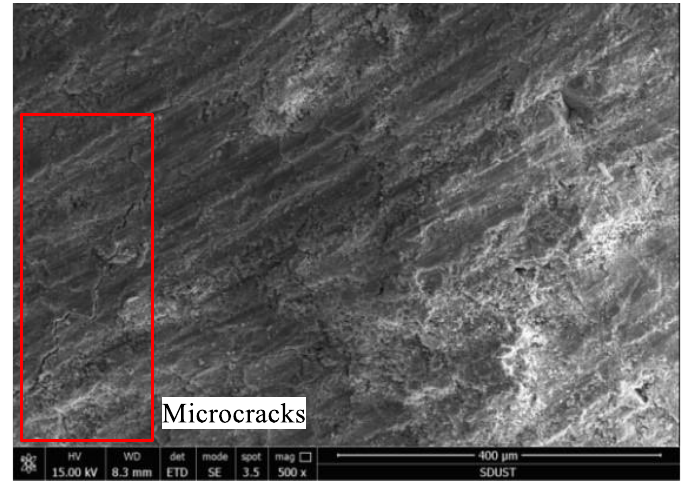
Figure 7. SEM image showing microcracks.